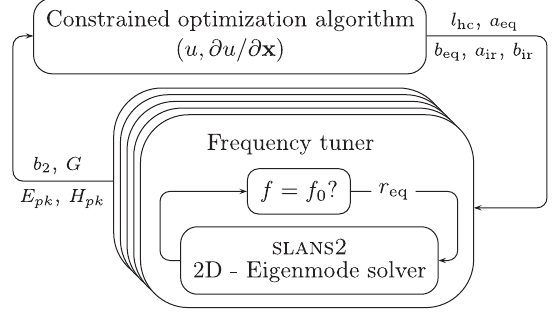
FIG. 5. Sketch of the cavity optimization. The optimizer minimizes the quality function u ð x Þ ¼ B pk =b 2 where x is a vector of free design variables such as a